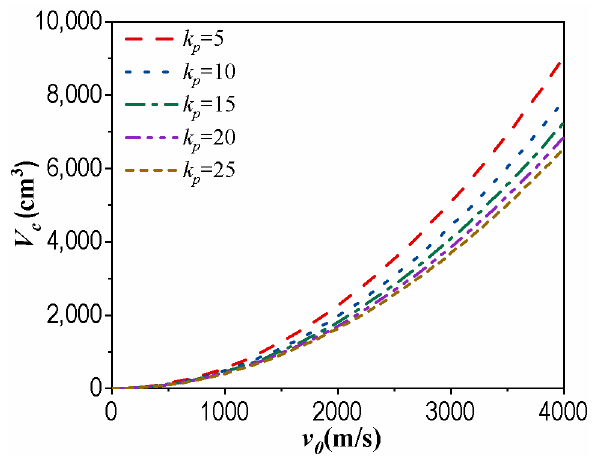
Appl. Sci. 2020 , 9 , x FOR PEER REVIEW Figure 18. Crater volume of di ff erent length to diameter ratio ( k p ) values under the same projectile mass. Figure 18. Crater volume of different length to diameter ratio ( k p ) values under the same projectile mass.